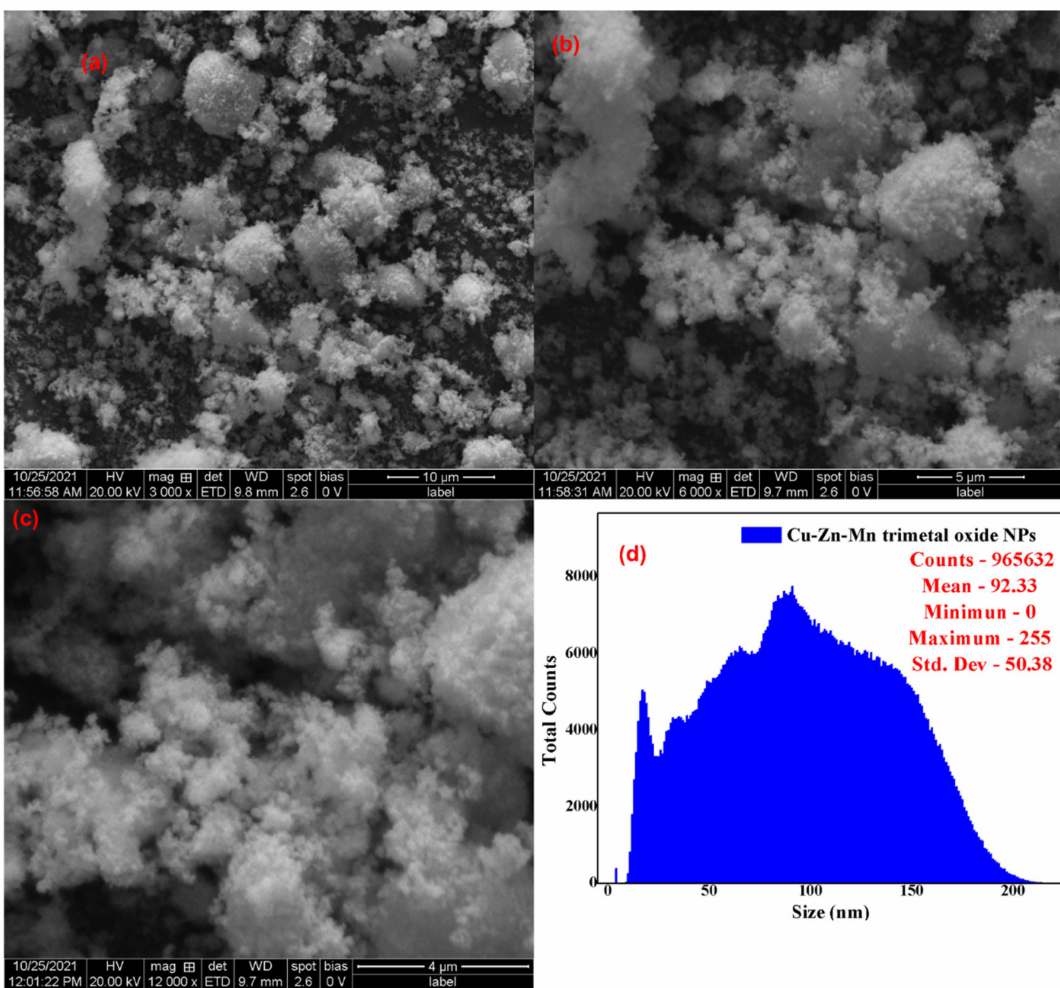
Figure 3. SEM of Cu-Zn-Mn mixed trimetal oxide nanoparticles. ( a ) 10 µ m; ( b ) 5 µ m; ( c ) 4 µ m; ( d ) size